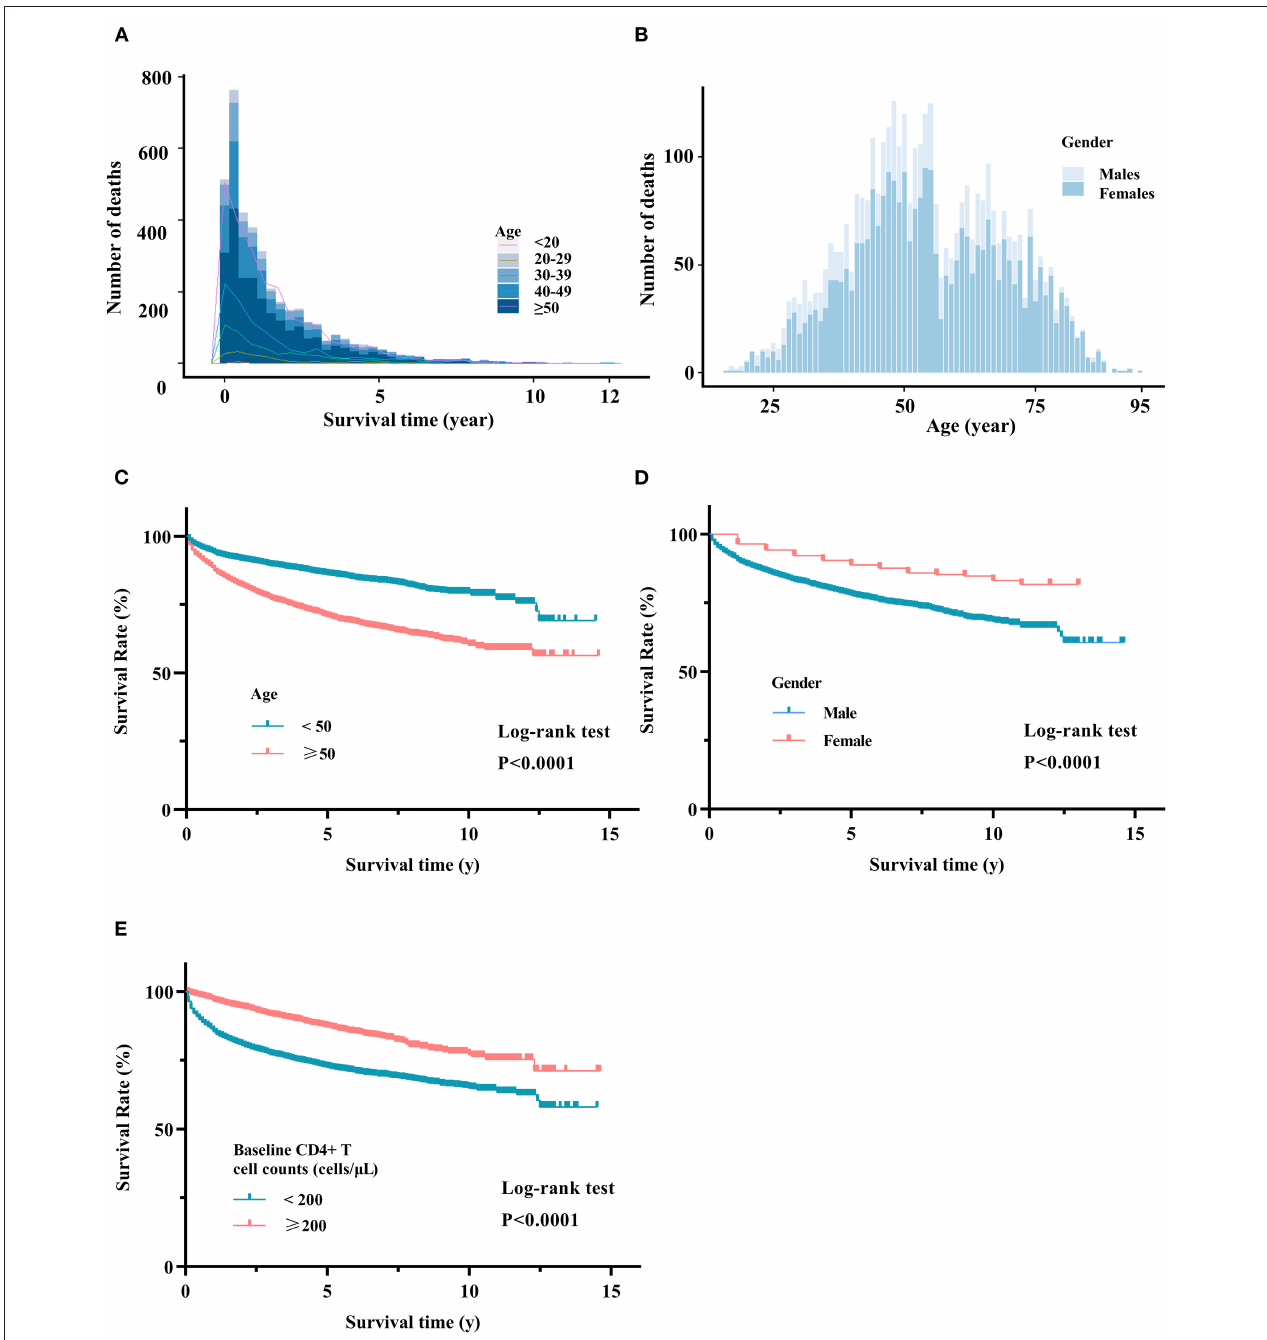
FIGURE 6 | Survival analysis of HIV-associated death. (A) Distribution of HIV-associated death in different age groups. (B) Distribution of HIV-associated death in males and females. Kaplan-Meier curves in different age groups (C) , gender groups (D) , and baseline CD4 groups (E) . Log-rank tests were used to measure the statistical